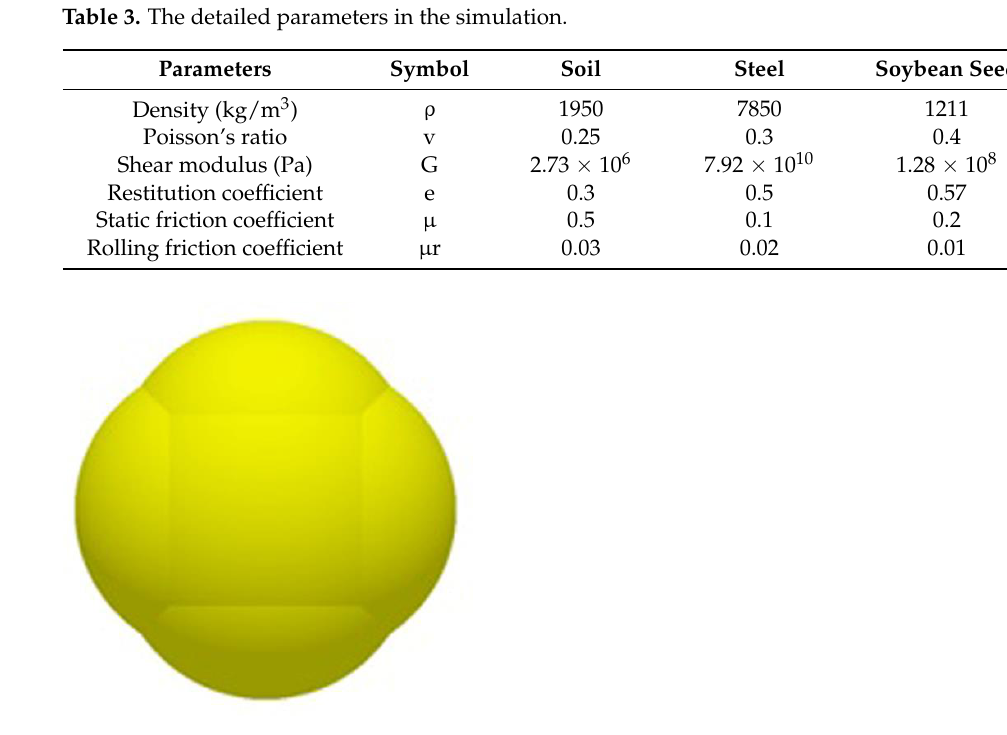
Figure 10. The 5-sphere model of a soybean seed in the DEM. Table 3. The detailed parameters in the simulation.